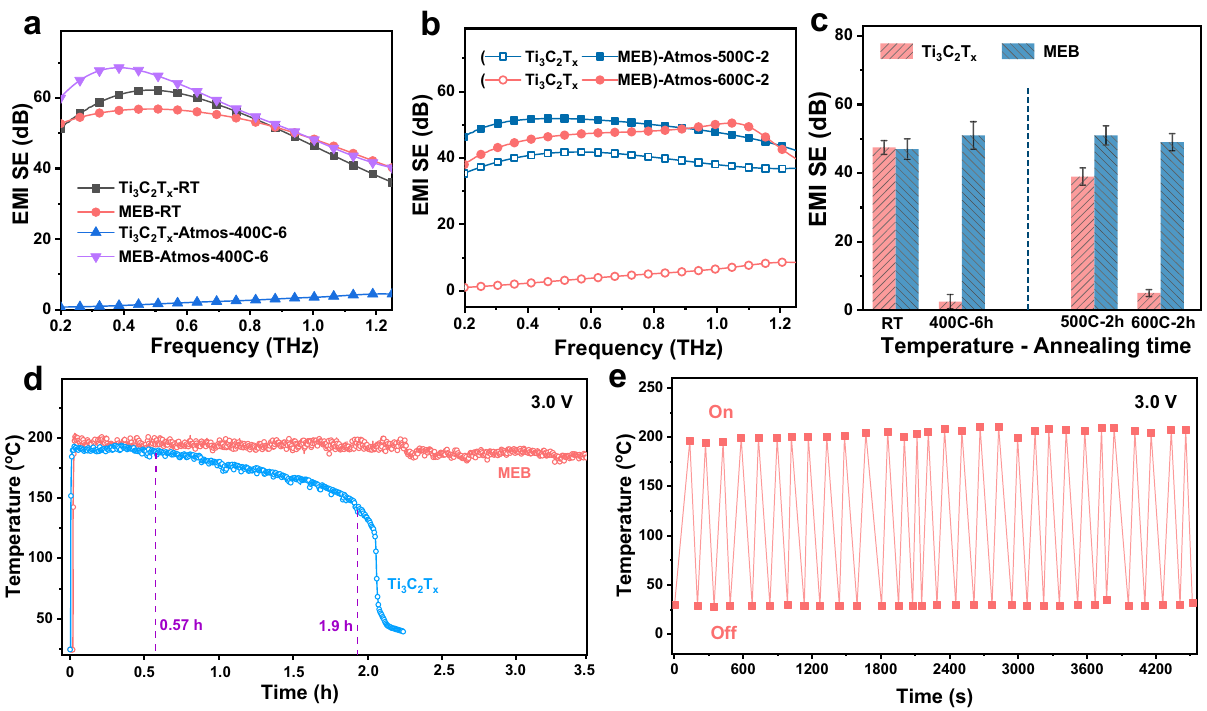
Fig. 5 | Potential applications of MEB. a – c THz EMI shielding property of MEB. a EMI SE in 0.2 – 1.3THz of Ti 3 C 2 T x -RT, MEB-RT, Ti 3 C 2 T x -Atmos-400C-6, MEB- Atmos-400C-6. b EMI SE in 0.2 – 1.3THz of Ti 3 C 2 T x -Atmos-500C-2, 600C-2, and MEB-Atmos-500C-2,600C-2. c TheaverageTHzSEofthesamplesshowedinFig.5a